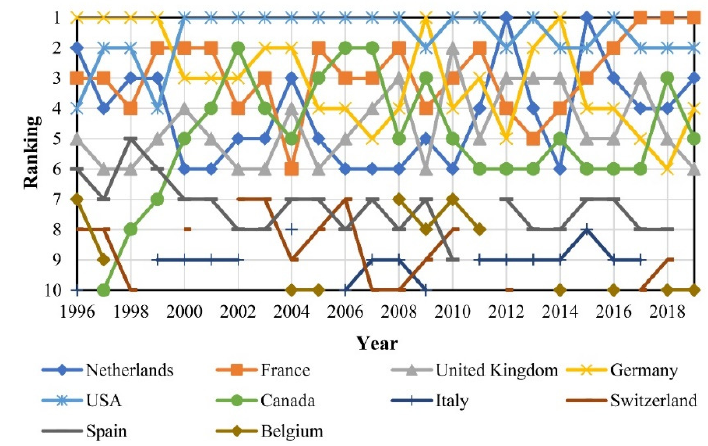
Figure 4. The top 10 countries in terms of the number of import partners over the years.